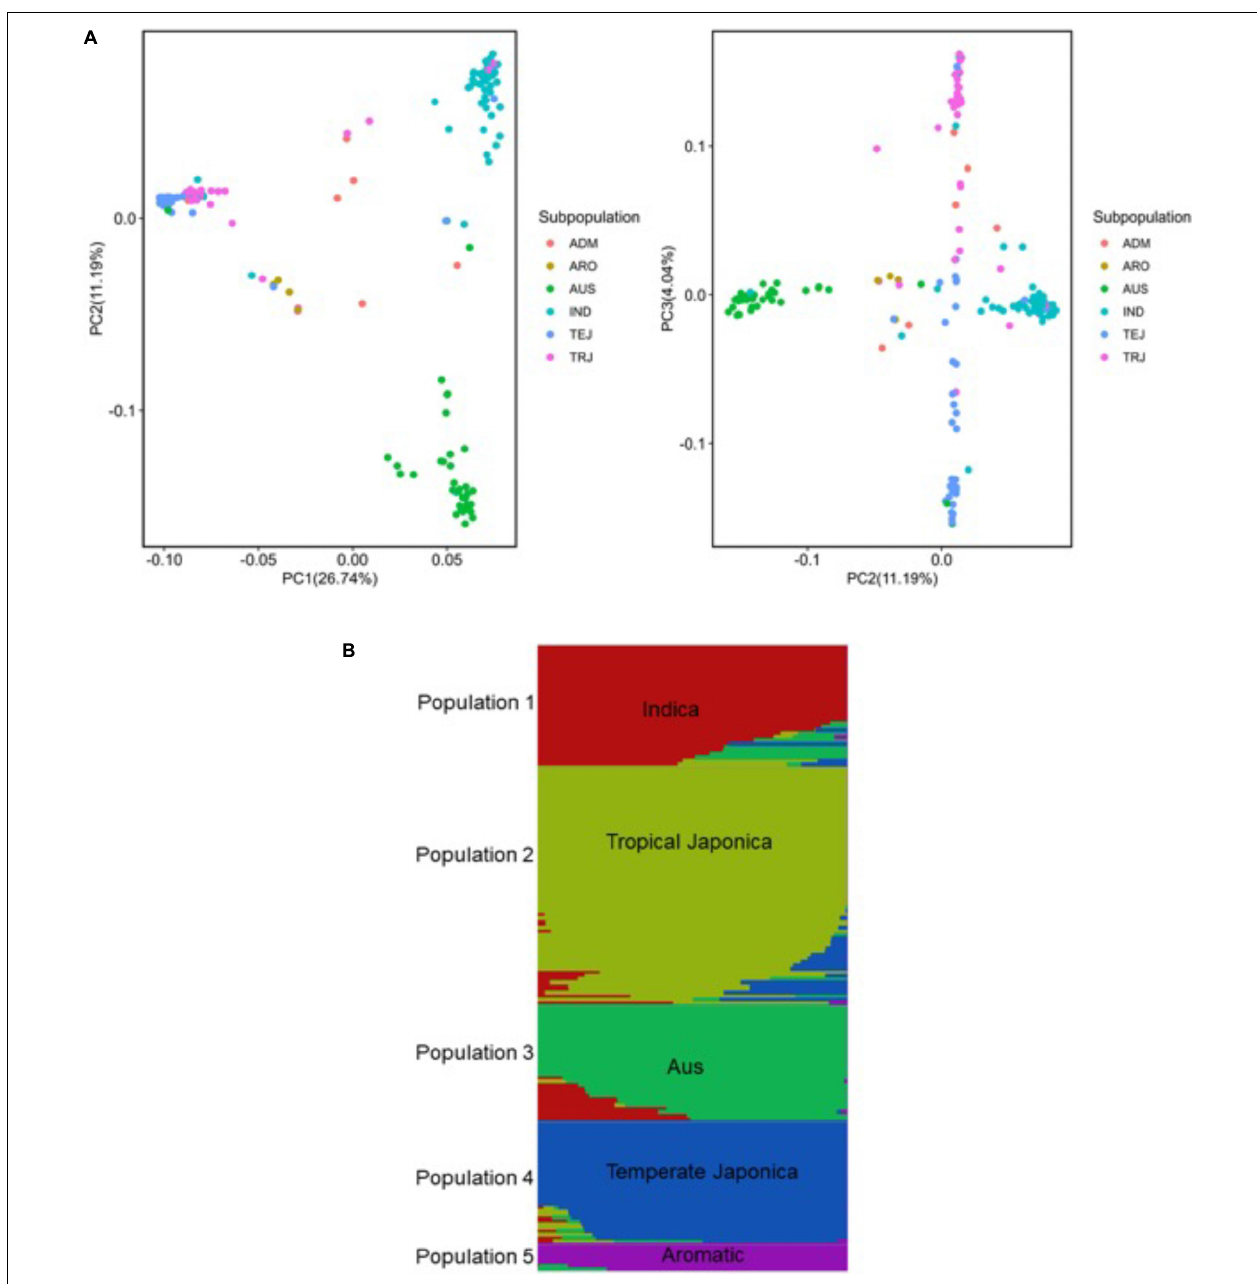
FIGURE 4 | Genetic structure analysis of the panel of 190 diverse rice accessions of the URMC. (A) Principal component analysis (PCA) revealing global genetic variation in the panel. Left: first and second principal components (PCs); right: second and third PCs. Three PCs visualized six subpopulations in the panel. The six subpopulations, Indica (IND), aus (AUS), aromatic (ARO), temperate Japonica (TEJ), tropical Japonica (TRJ), and Admixture (ADM)-mixed subpopulations, are colored as indicated. (B) Population structure of the panel of 190 diverse rice accessions of the URMC; single vertical lines represent each accession and each color represents a subpopulation cluster as designated by fastSTRUCTURE. Right: the number of populations ( K = 5) using delta marginal likelihood provided by fastSTRUCTURE and the delta marginal likelihood values are plotted against the number of populations ( K = 5).